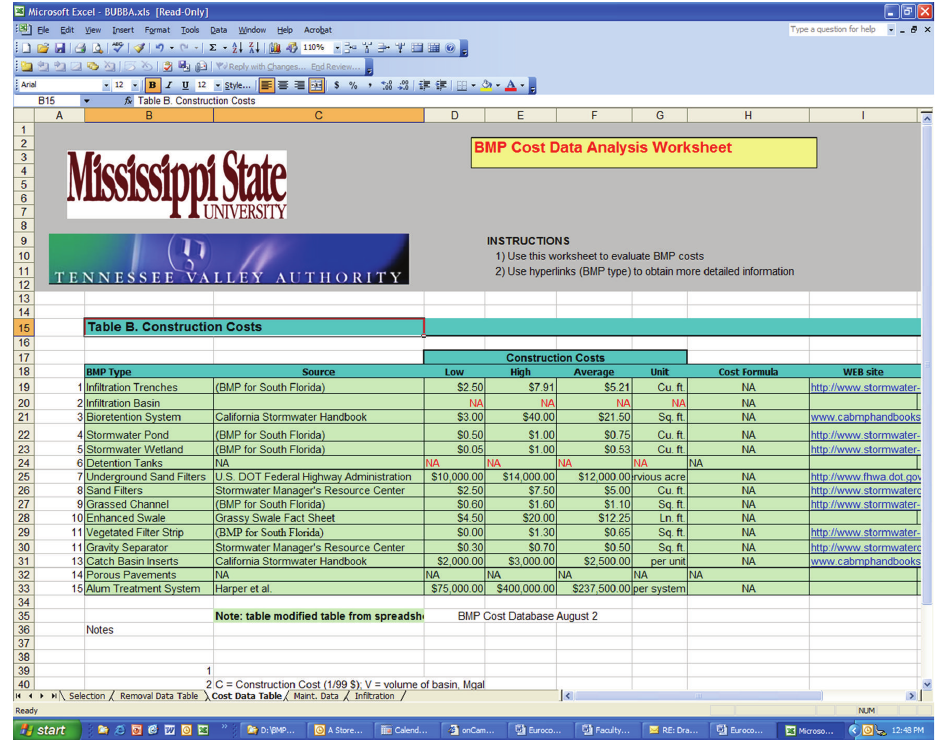
Figure 4: The Cost Data Table worksheet.